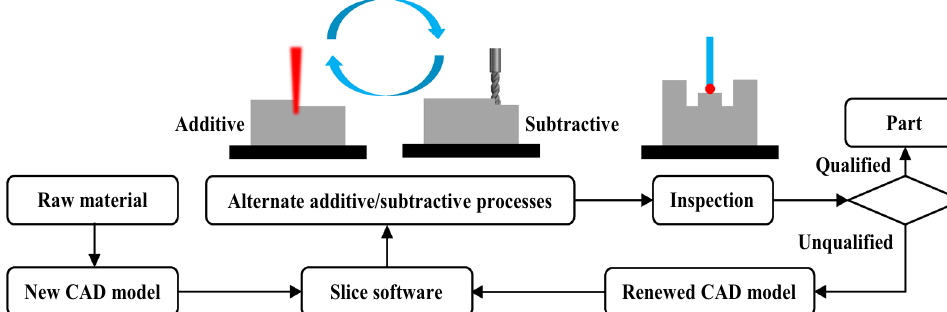
Figure 1 SLM/HSM hybrid manufacturing system